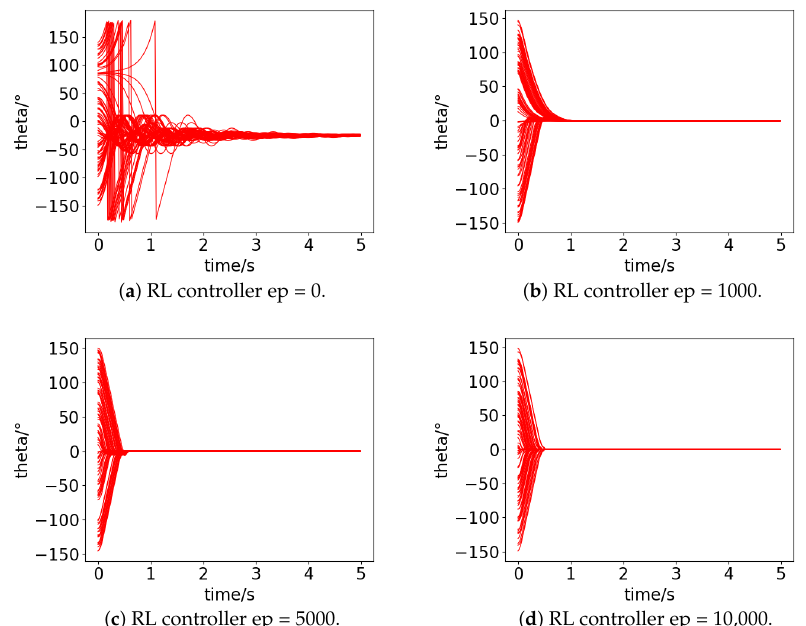
Figure 12. Recover tests for the RL controller in different episodes.